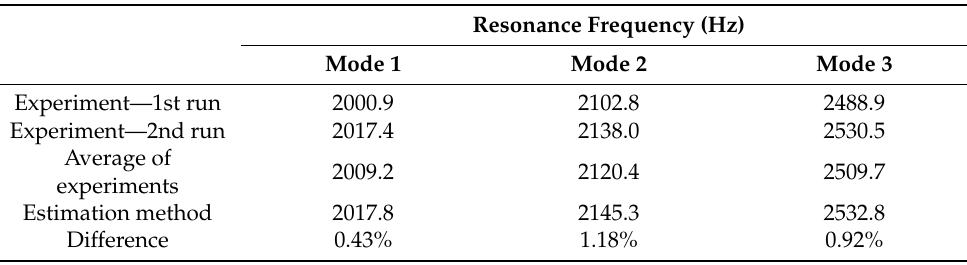
Table 5. Comparison of estimated resonance frequencies with experimental tests for the satellite antenna.